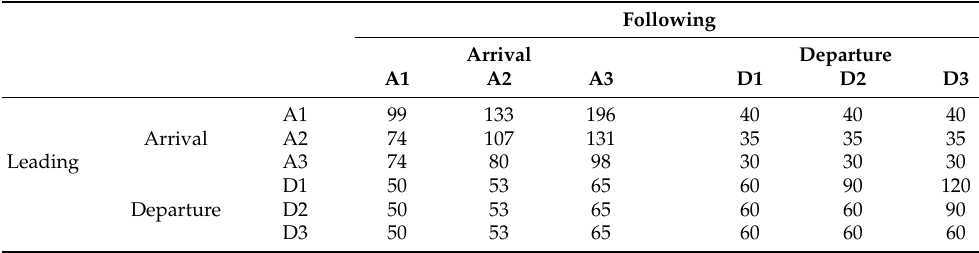
Table 1. MST (in sec.) between successive aircraft on the same runway for three aircraft types with two status